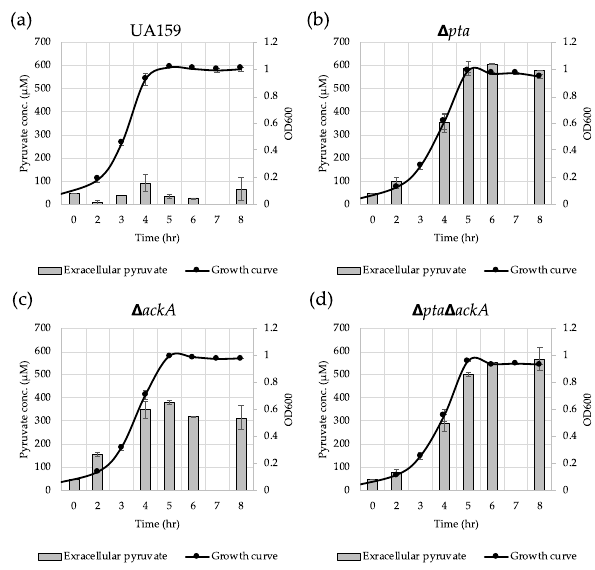
Figure 8. Measurement of extracellular pyruvate during growth of S. mutans UA159 wild type and Pta-AckA pathway derivative strains. Wild type ( a ), ∆ pta ( b ), ∆ ackA ( c ) and ∆ pta ∆ ackA ( d ) strains were grown in BHI. For time course measurements of extracellular pyruvate and growth, samples were taken at 1 or 2 h intervals (see Materials and Methods for details). The concentration of pyruvate was determined using an EnzyChrom ™ pyruvate assay kit, and growth was measured by the optical density at 600 nm (OD 600 ). Bars indicate the average concentration of extracellular pyruvate and a solid line with black circles indicates the corresponding growth curve. The results are an average of two independent experiments. Error bars = standard deviation.